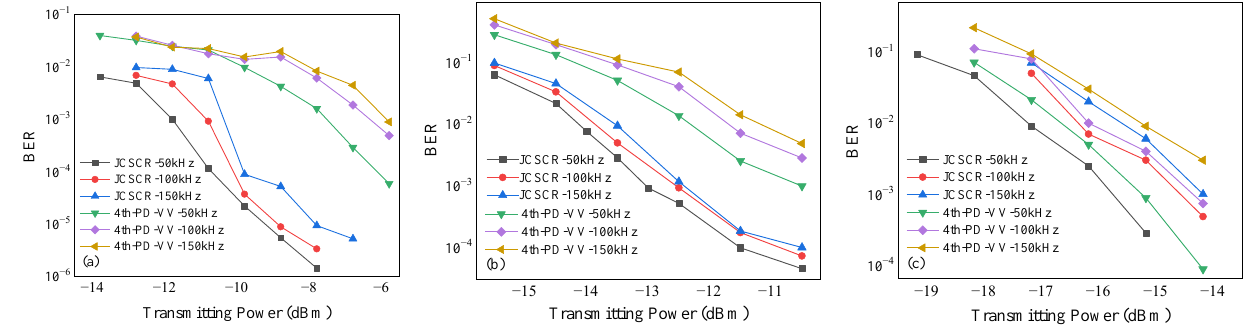
Figure 7. Normalized MSEs as functions of different frequency offsets: ( a ) 6.5 × 10 -14 𝑚 −2 3⁄ , ( b ) 5 × 10 - 15 𝑚 −2 3⁄ , and ( c ) 6 × 10 -16 𝑚 −2 3⁄ .